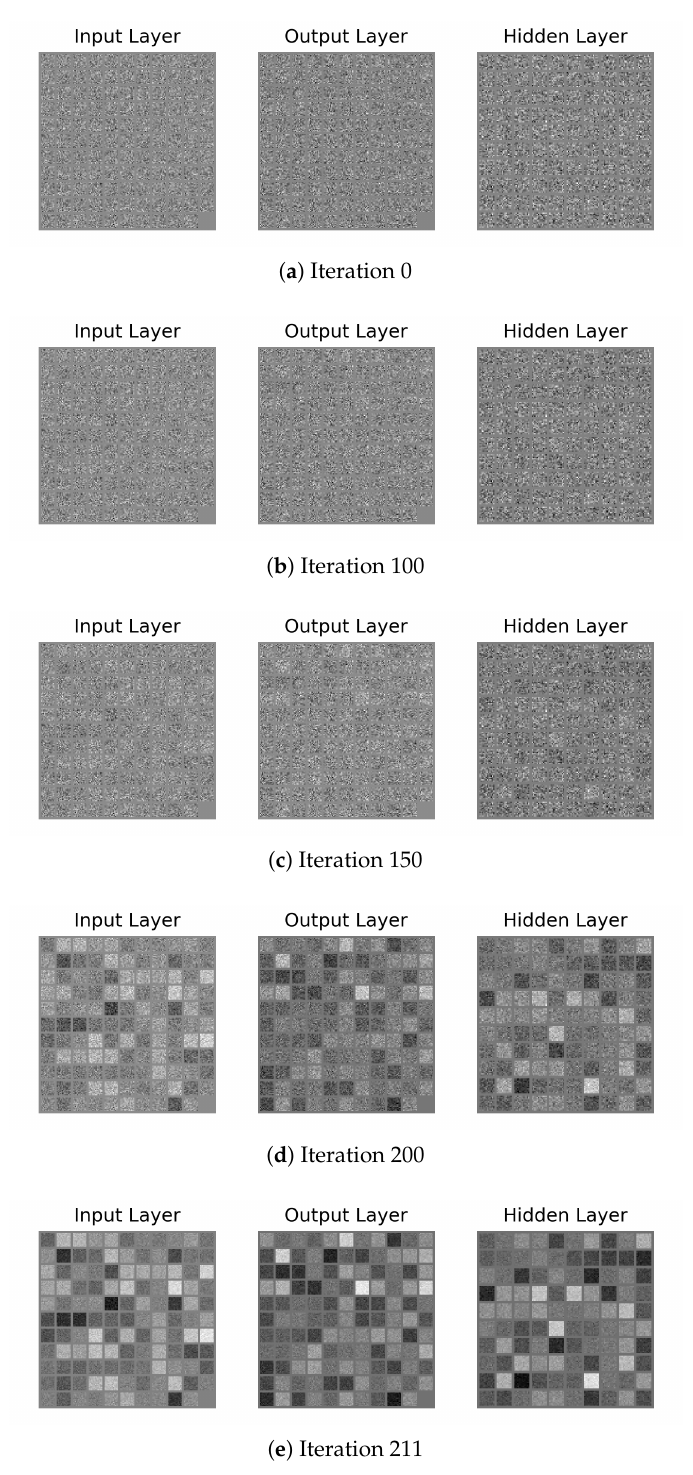
Figure 8. Image filters learned from shifted random images at different